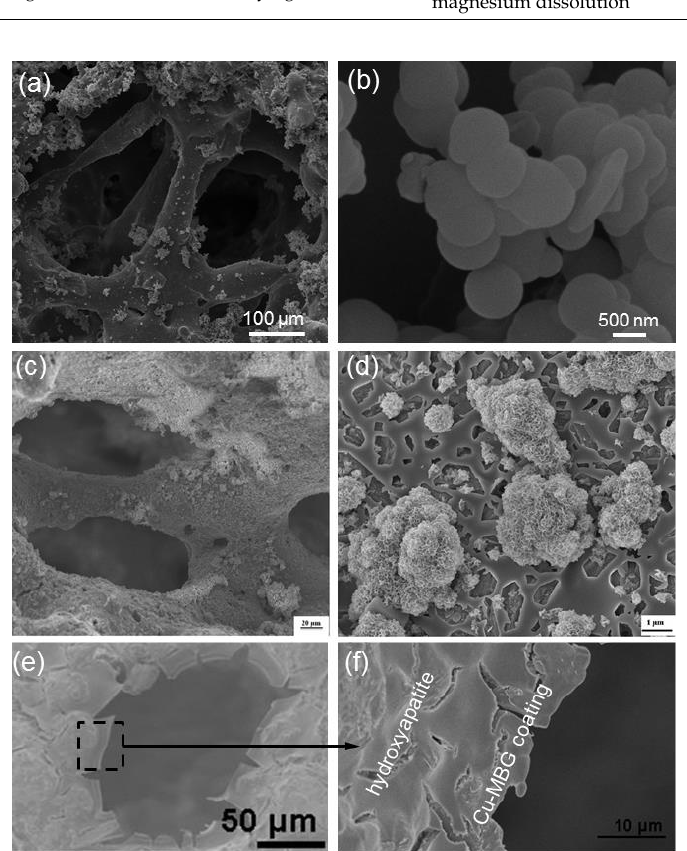
Figure 4. Ceramic scaffolds provided with a mesoporous coating (SEM micrographs are reported): ( a ) MCM-41 spheres deposited on a bioactive glass–ceramic foam; and ( b ) detail of the pure silica mesoporous particles anchored on the scaffold struts (images adapted from Vitale-Brovarone et al. [38] © Springer); ( c ) CaSiO 3 -based scaffold coated with a MBG coating deposited by electrophoretic deposition to improve bioactivity, as demonstrated by the surface apatite agglomerates formed after 2 days in SBF (simulated body fluid) ( d ) (images adapted from Fiorilli et al. [45] © Springer); ( e,f ) Cu-doped MBG layer applied on a hydroxyapatite orbital implant to impart antibacterial properties (images adapted from Ye et al. [49] ©